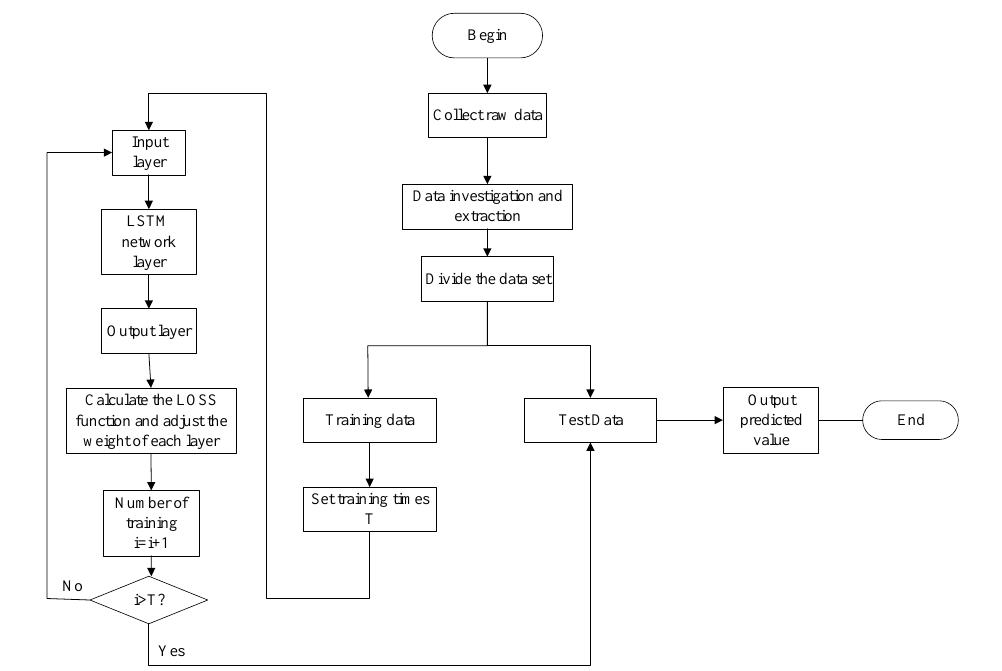
Figure 5. Model flow chart.